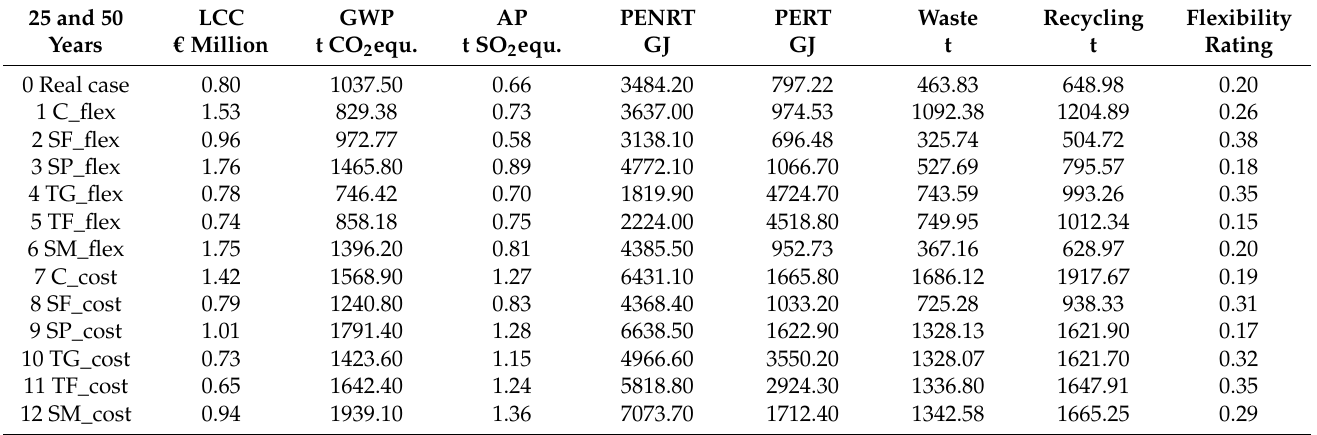
Table 4. LCC, LCA criteria, recycling potential and flexibility rating results of the examined structural systems of the building variants for the time scenarios 20 and 50 years.